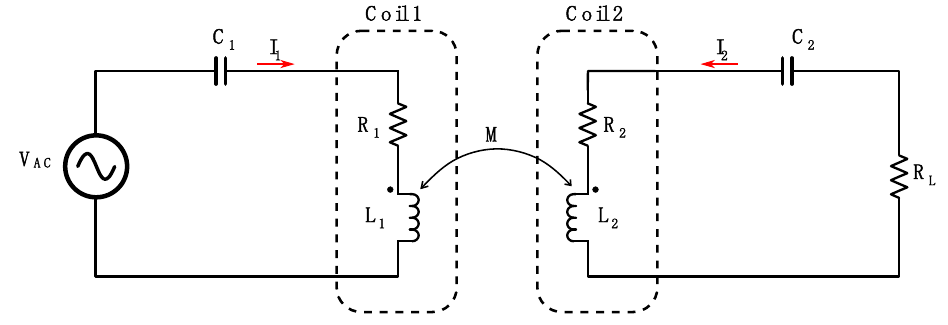
Figure 4. Two magnetically coupled resonant loops using series-series compensation.